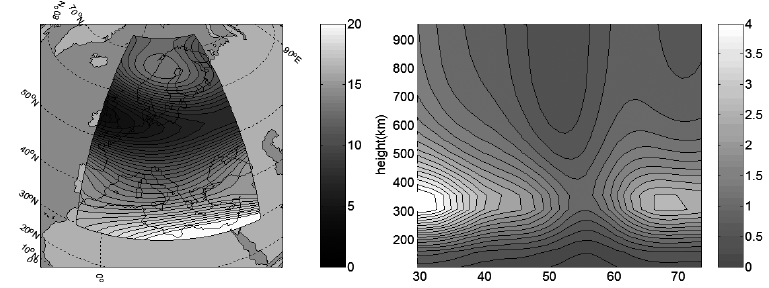
Fig. 8.14. ( Left panel) Frame from a movie of vertical TEC (in TECU) over Europe obtained from the inver- sion of GPS data recorded about 22 UT on 12 August 2000; ( right panel) corresponding plot of electron con- centration ( × 10 11 m -3 ) at 15°E